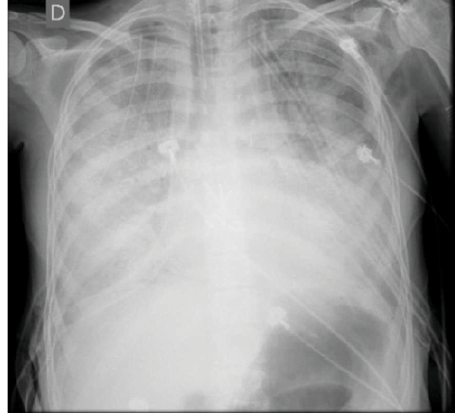
Figure 2 - Chest X-ray immediately after orotracheal intubation showing diffuse bilateral opacities that are compatible with primary graft dysfunction after lung transplantation